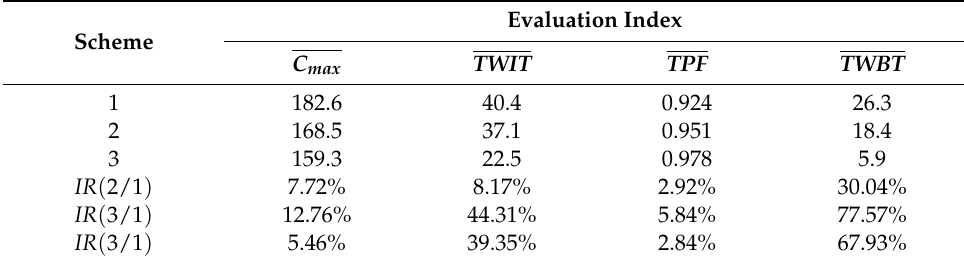
Table 3. Comparison of evaluation indexes for the three scheme scheduling